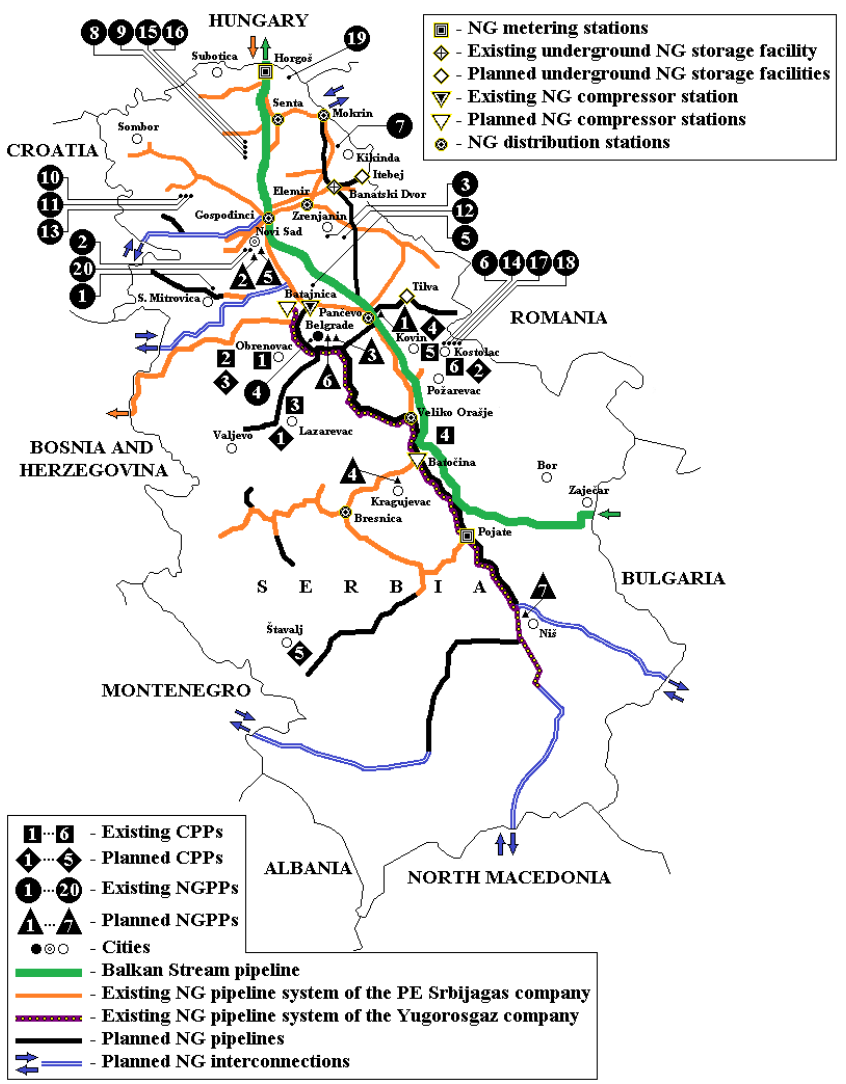
Figure 5. The layout of the existing and planned CPPs and NGPPs with respect to the part of the Balkan Stream pipeline running across Serbia and with respect to local NG pipeline systems.